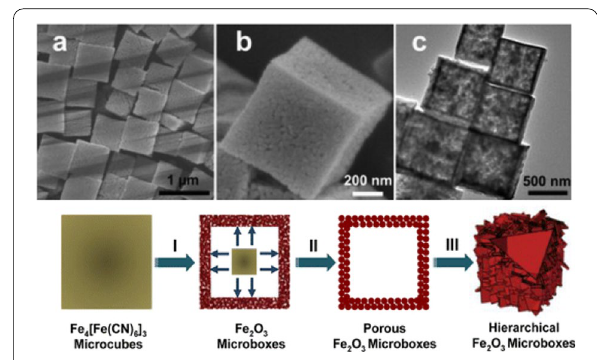
Fig. 6 a , b FESEM and c TEM images of hollow Fe 2 O 3 microboxes obtained at 350 °C. d Schematic illustration of the formation of hollow Fe 2 O 3 microboxes and the evolution of the shell structure with the increasing calcination temperature. Reprinted with Permission from [54]. Copyright, American Chemical